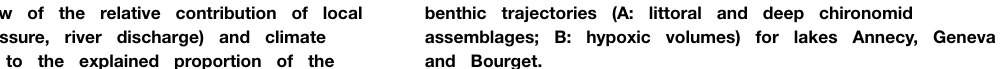
FIGURE 5 | Synthetic view of the relative contribution of local (TP, fish predation pressure, river discharge) and climate (Air warming) forcings to the explained proportion of the